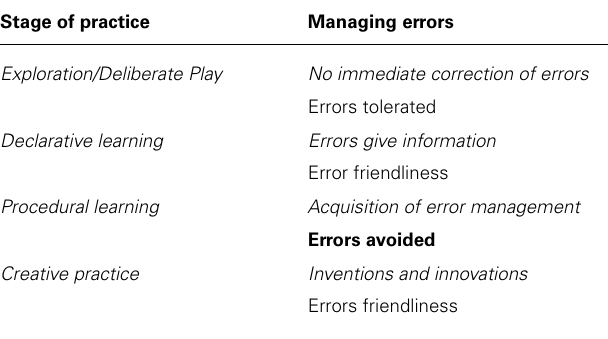
Table 3 | Stages to expertise in terms of handling errors (Kruse-Weber and Parncutt, 2013). Stage of